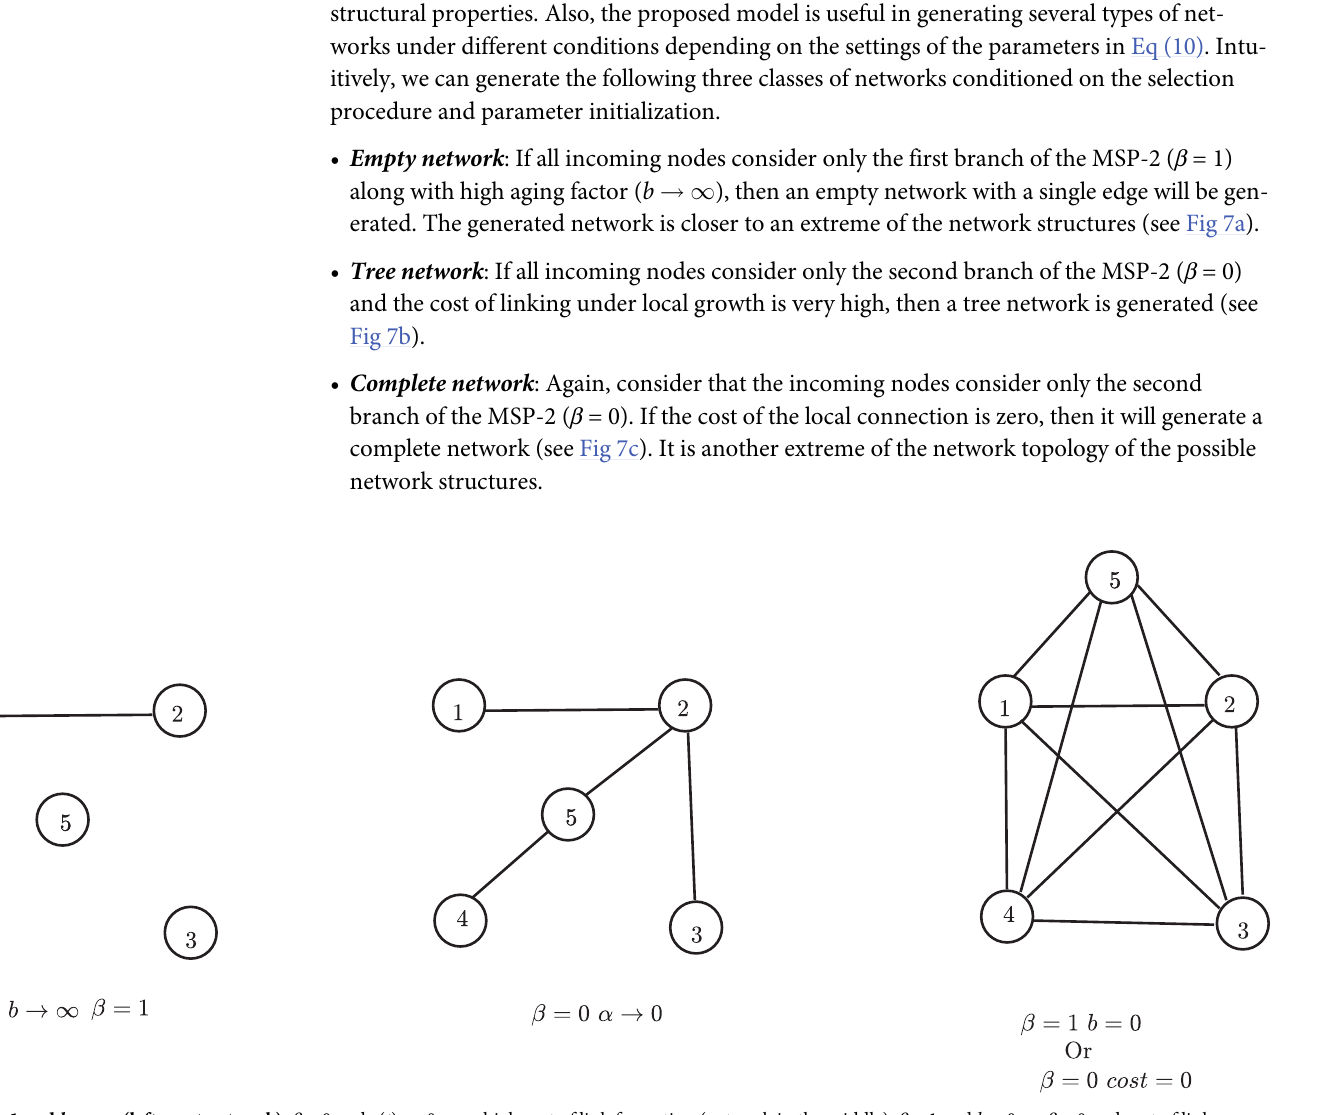
Fig 7. β = 1 and b ! 1 (left most network). β = 0 and g ( t ) ! 0, very high cost of link formation (network in the middle). β = 1 and b = 0, or β = 0 and cost of link formation is zero (right most network).